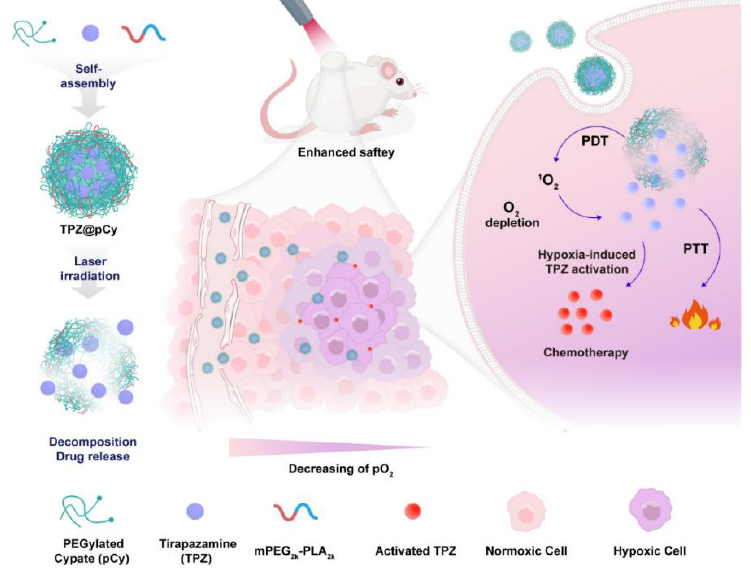
Figure 3. Schematic illustration of the fabrication process of TPZ@pCy and its mechanism of action for achieving controllable decomposition of nanocargo and delivery and activation of tirapazamine (Adapted and reused with permission from [65], MDPI 2022 under CCBY license).